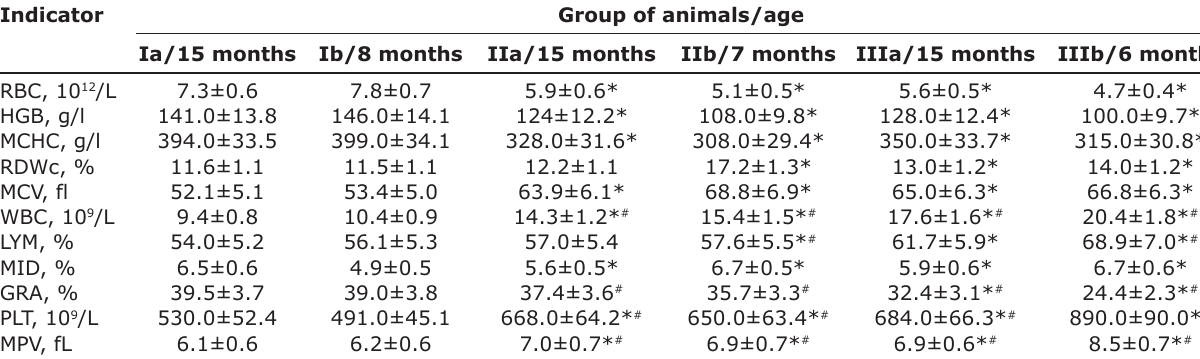
Table-3: Hematological parameters of rats (experiment of 9 months).